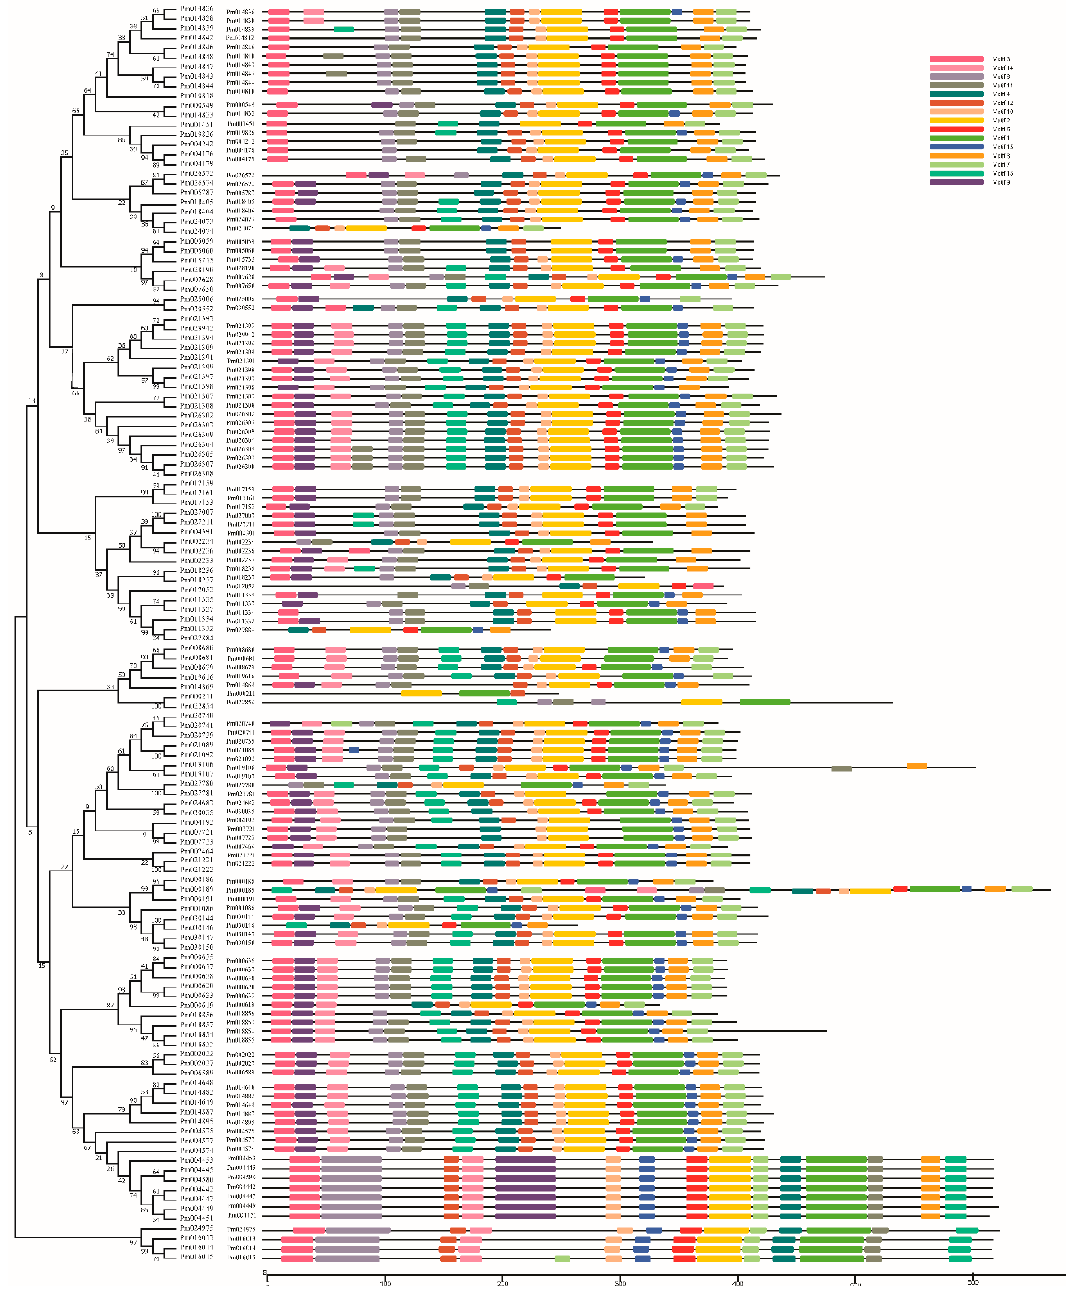
Figure 4. Motif distribution in PmUGTs . Motifs were analyzed using the MEME web server. The motifs are represented by different colors.